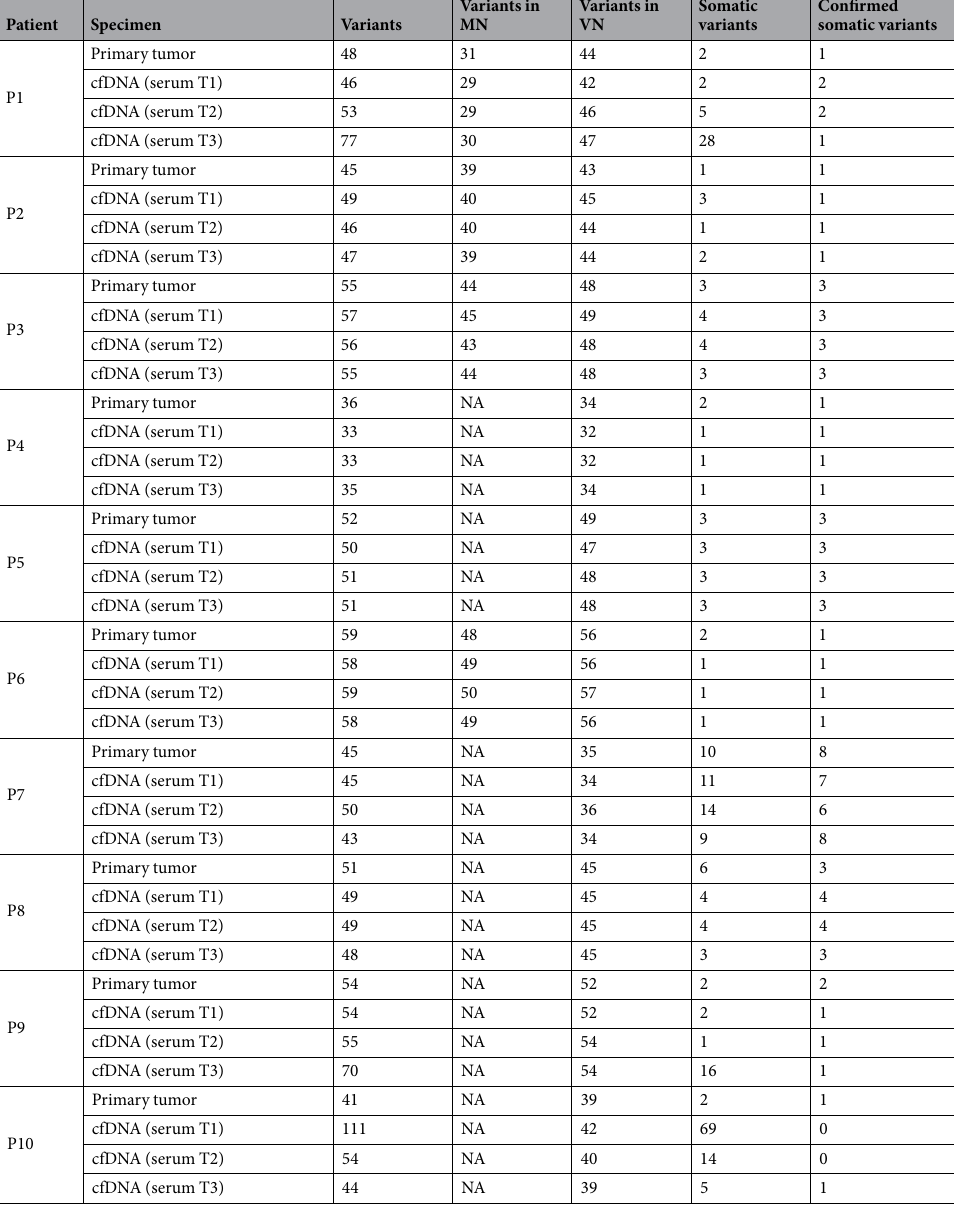
Table 1. Variant detection in primary tumor and serum-derived cfDNA specimens. Number of variants (columns) in each specimen for each of the ten patients (rows). The columns indicate 1) total variants detected, 2) variants in the indicated specimen also detected in the matched normal specimen (if available), 3) variants in the indicated specimen also present in at least one Virtual Normal genome, 4) variants classified as somatic variant (criteria in manuscript) and 5) somatic variants in the indicated specimen also confirmed in at least one additional patient-matched